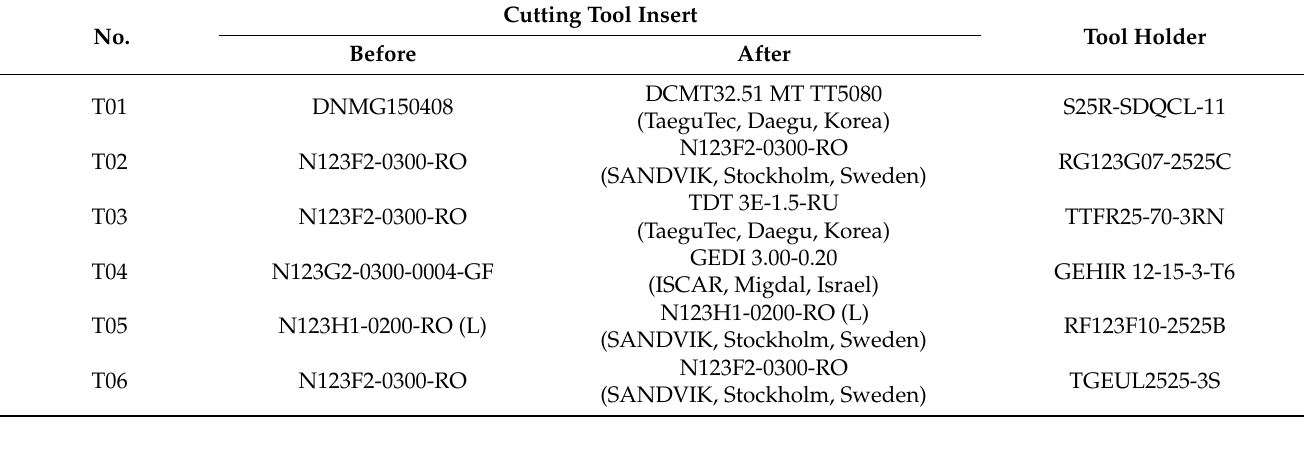
Table 4. Cutting tool inserts and tool holders for final test.